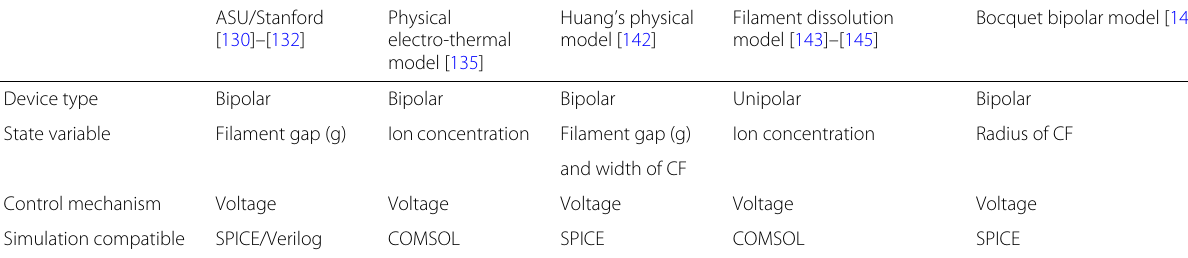
Table 5 Comparison of RRAM